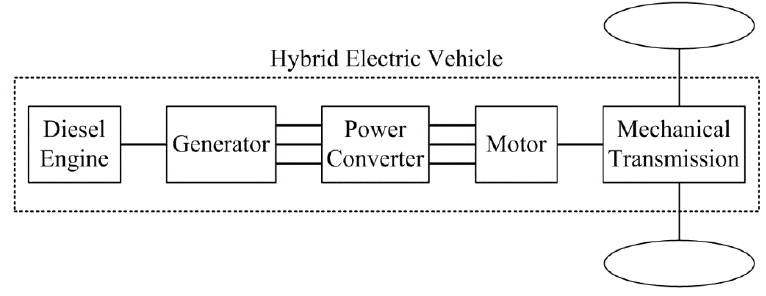
Figure 1. Structure of the hybrid electric vehicle classified into five basic